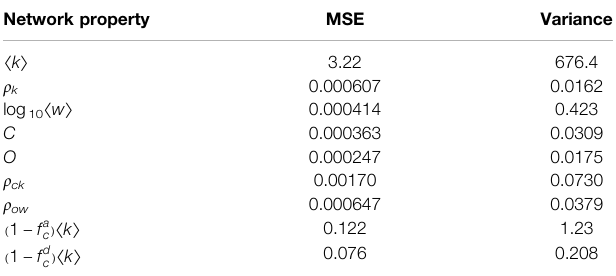
TABLE3| Meansquarederror(MSE) ofthemetamodelsobtainedforeachoutput feature. The variances of the test dataset are also shown as a reference. Network